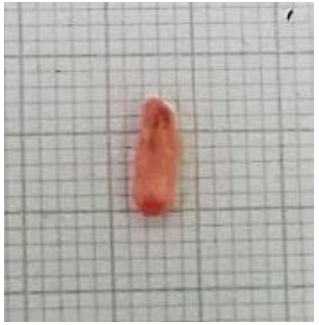
Fig. 1. Morphological identification of Paramphistomum